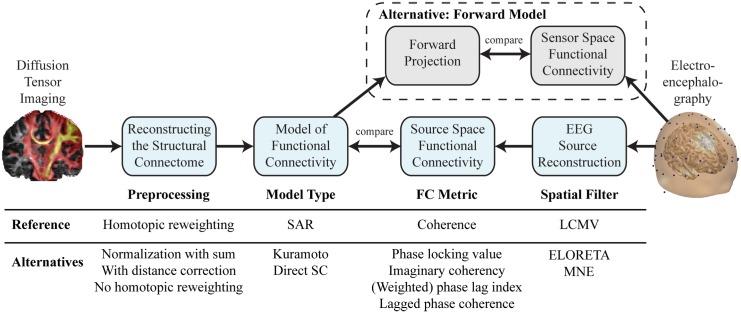
Workflow from DTI to the model of functional connectivity and comparison with empirical EEG data.Each processing step in the reference procedure can be replaced by several alternative methods. From left to right: Probabilistic tracts derived from DTI are preprocessed to give the structural connectivity matrix. From there we simulate functional connectivity and optimize free model parameters to maximize the global correlation with the empirical functional connectivity. The empirical functional connectivity is calculated between all pairs of ROIs after projecting EEG scalp recordings to source space using spatial filters. Alternatively, the comparison between simulated and empirical connectomes can be done in sensor space by projecting the simulated functional connectivity into sensor space using the leadfields.